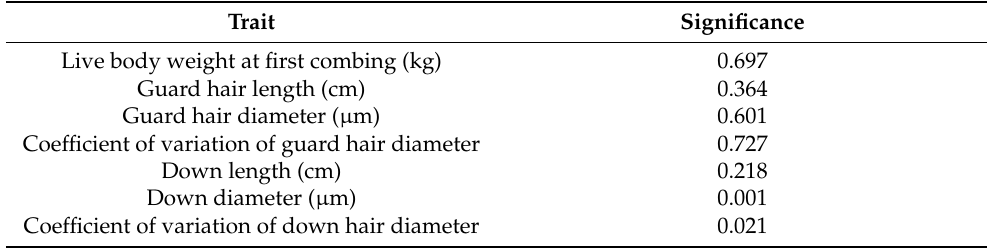
Table 2. Summary table of Kruskal–Wallis test results comparing fiber traits between males and females (significance level of 0.05).